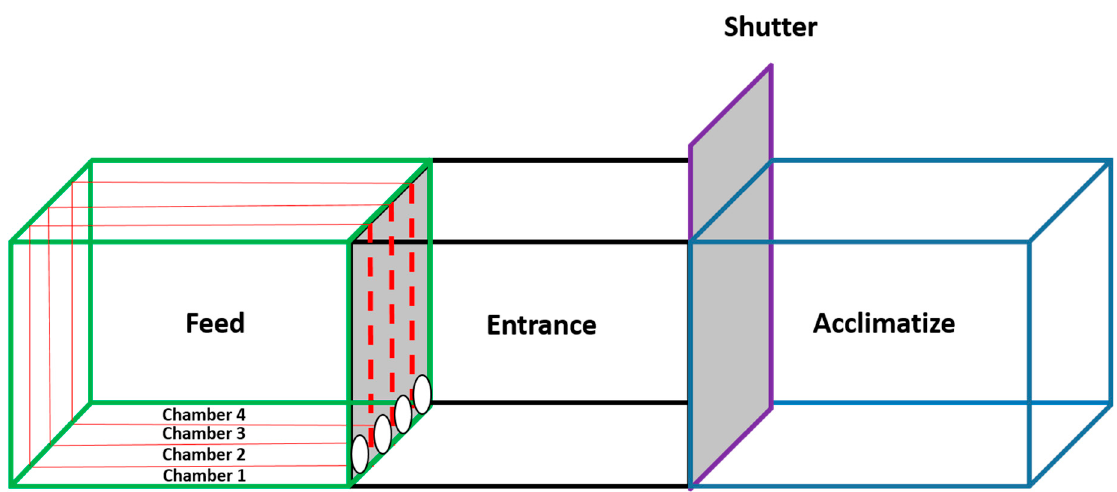
Figure 3. Pictorial representation of test setup used for shrimp palatability testing.